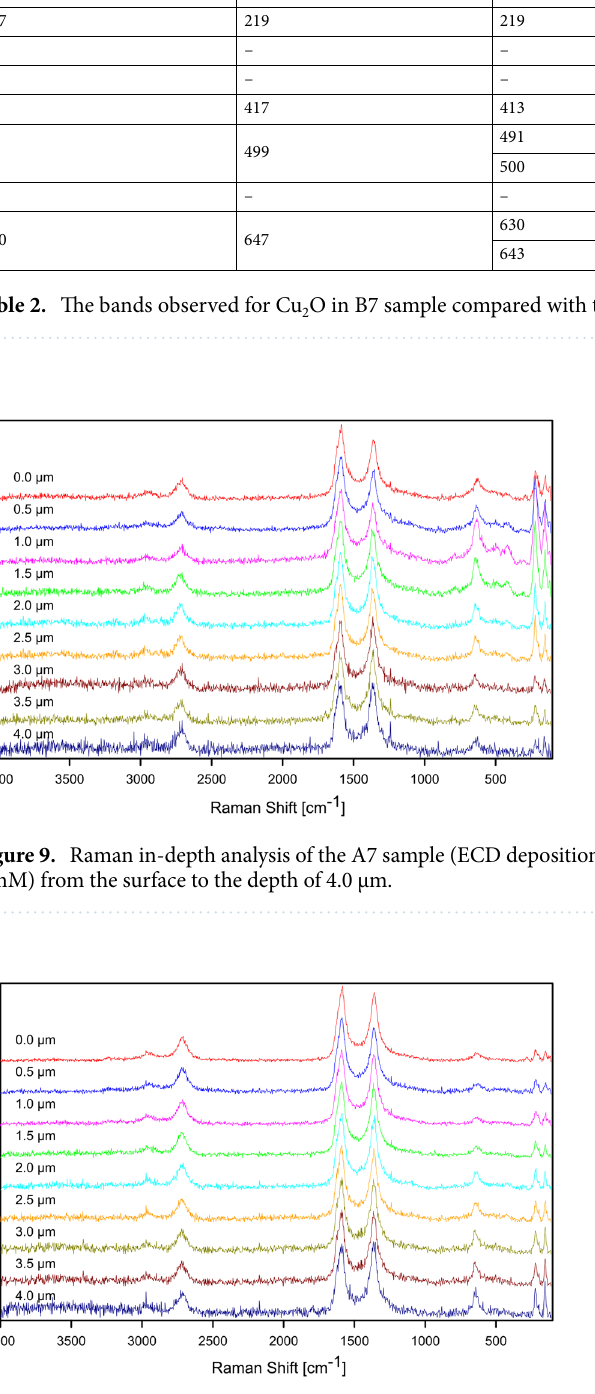
Figure 10. Raman in-depth analysis of the B7 sample (ECD deposition time of 600 s, CuSO 4 concentration of 100 mM) from the surface to the depth of 4.0